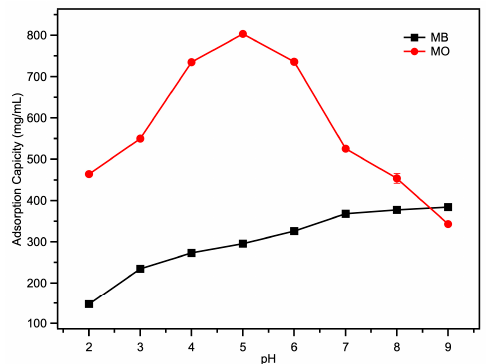
Figure 5. Effect of initial pH on adsorption capacities of Fe-loaded MOF-545(Fe) for MB and MO.